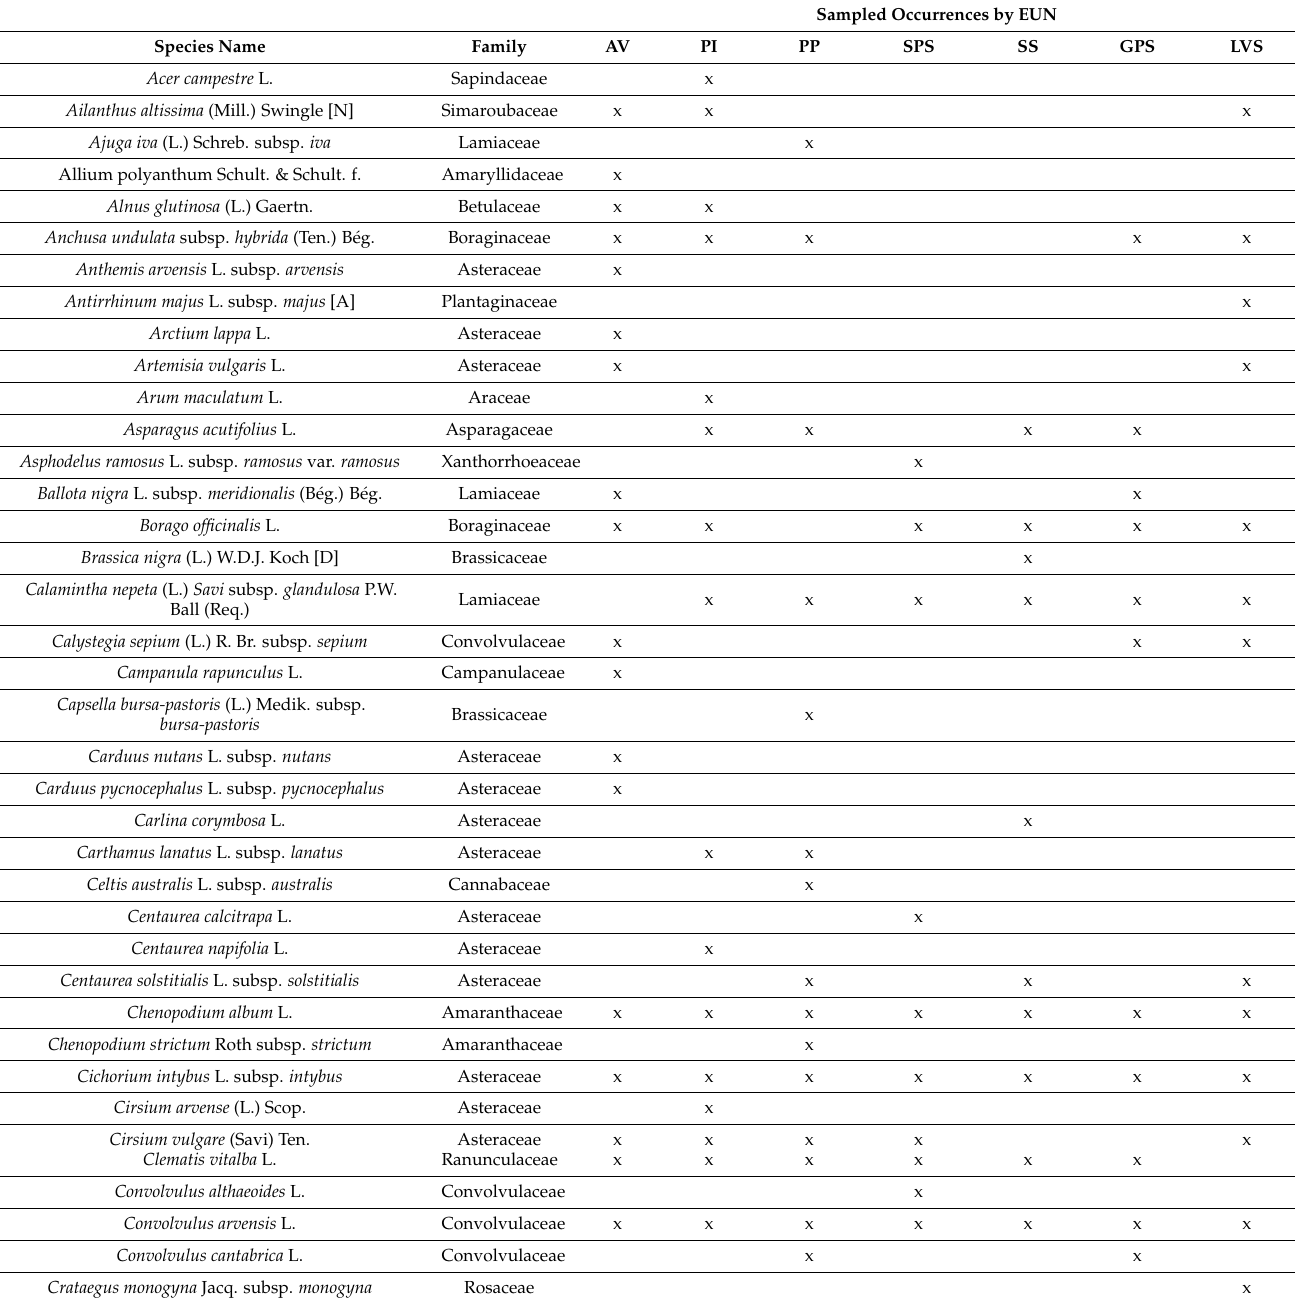
Table A2. List of the vascular flora of apiarian interest detected in the study area by environmental unit (EUN). Plant species are also qualified in terms of non-native/cultivated status (retrieved from Celesti-Grapow et al. 2013 [73]): [A] = archaeophyte, [N] = neophyte, [D] = doubtful alien, [C] = cultivated/cultivation escapees. EUNs codes: AV = Alluvial valleys, PI = Pyroclastic impluvia, PP = Pyroclastic plateaus, SPS = Steep pyroclastic slopes, SS = Sedimentary clayey and sandy hill slopes, GPS = Gentle pyro-clastic slopes, LVS = Lithoid volcanic